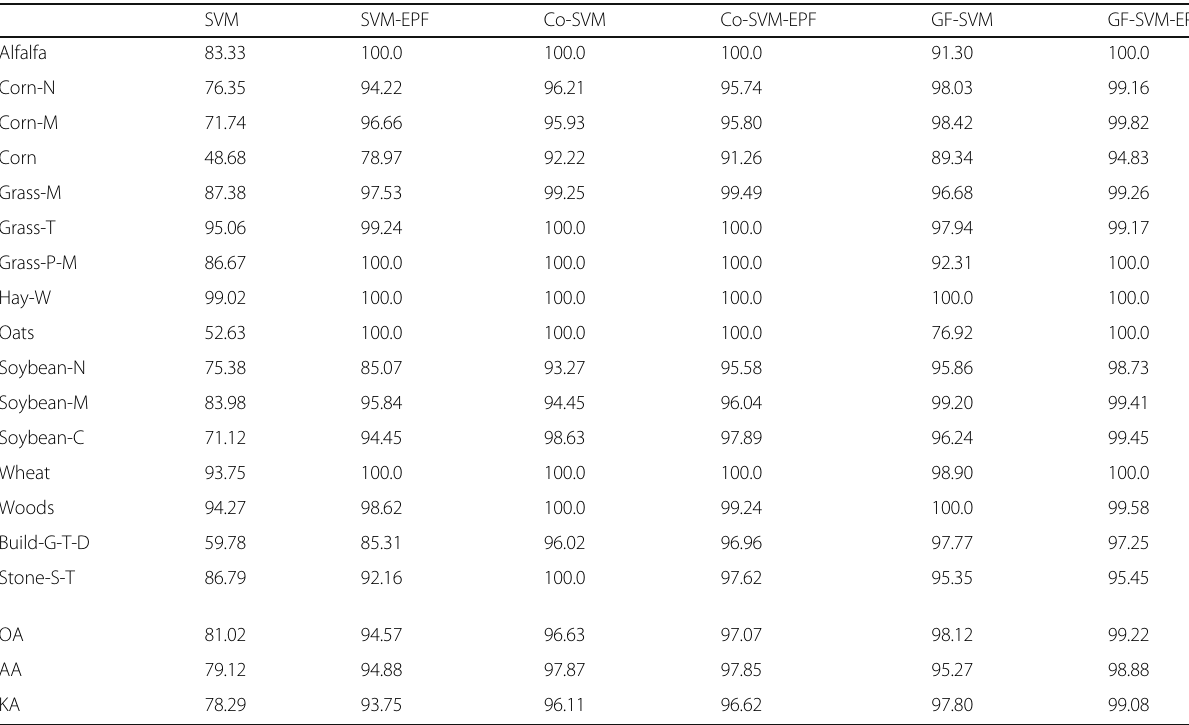
Table 1 Classification accuracy on the Indian Pines dataset (10% samples for training)